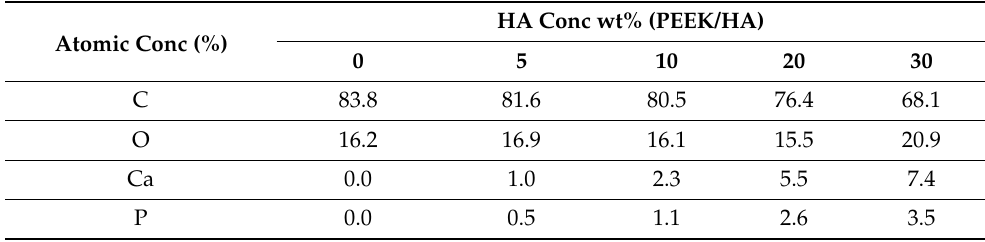
Table A2. Elemental composition of 3D printed materials with the HA content between 0–30 wt% incorporated in PEEK, obtained by SEM-EDX spectrum at 1000 ×